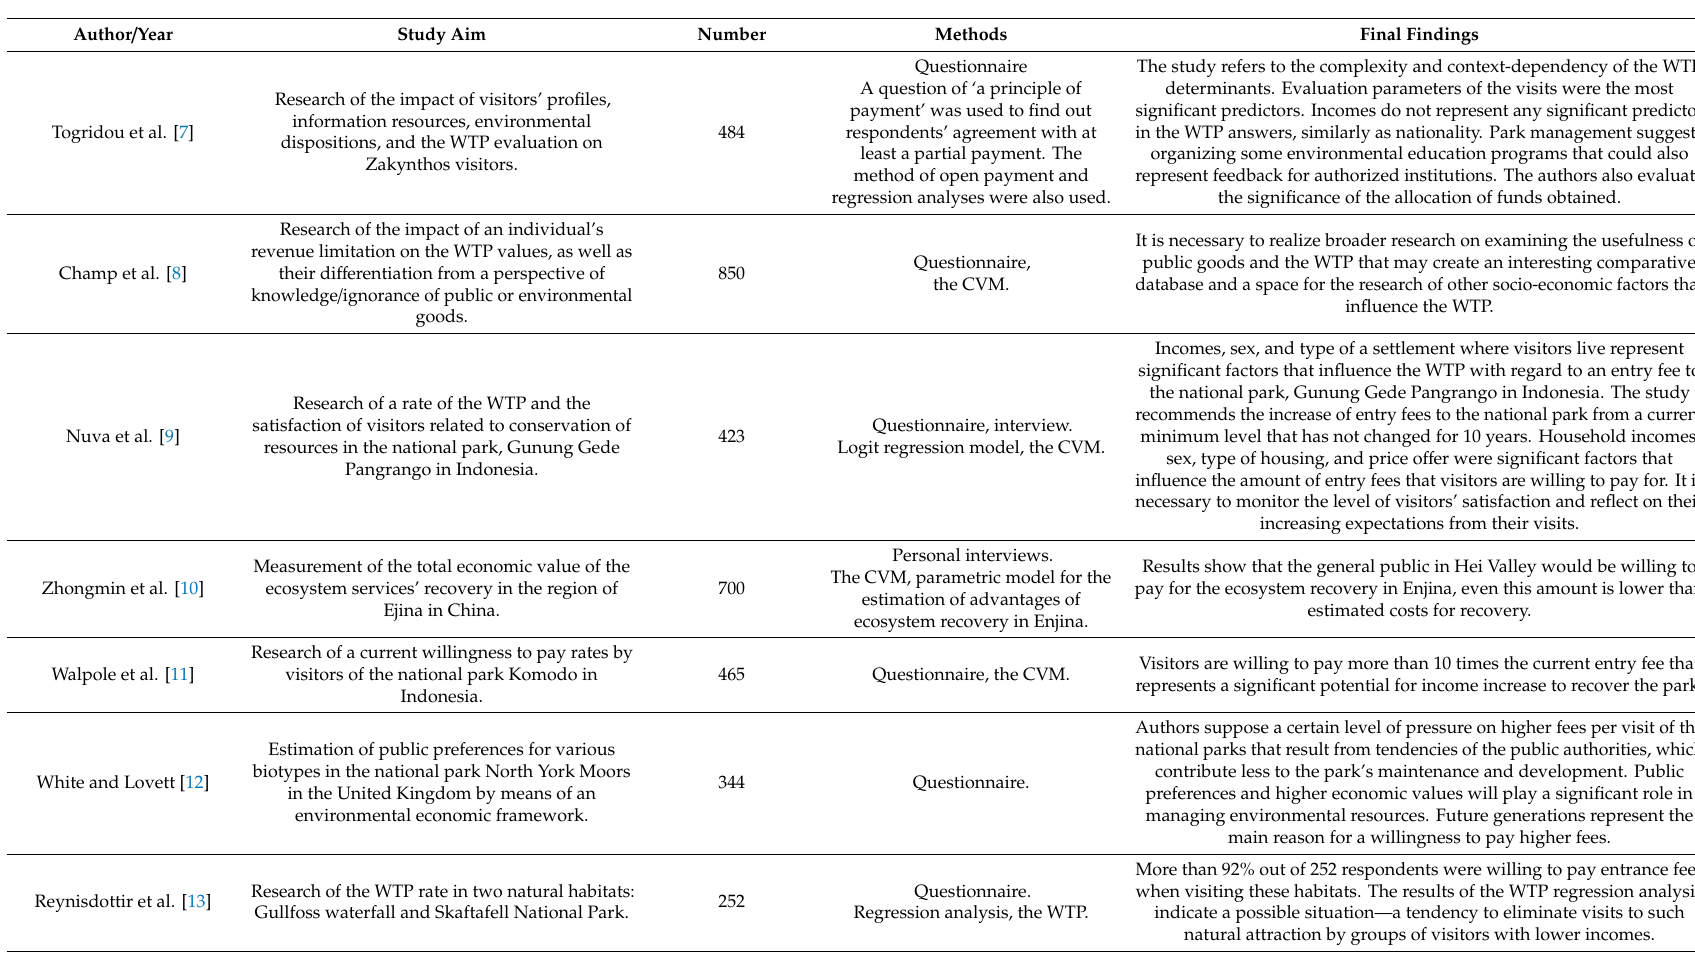
Table 1. Overview of foreign research studies of the WTP issue [explanatory notes: the WTP—Willingness to Pay, the CVM—Contingent Valuation Method, the OLS—Ordinary Least